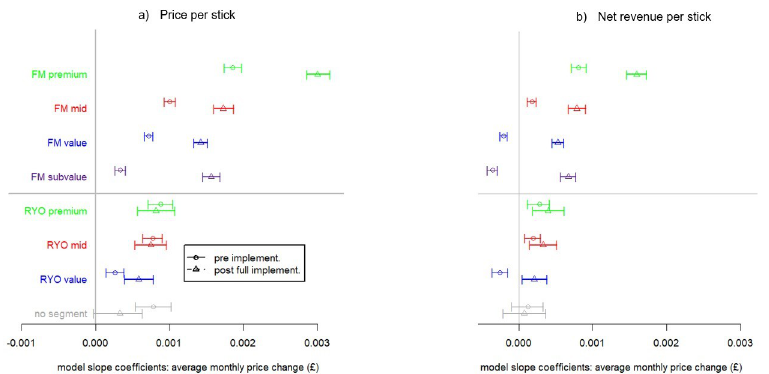
Fig 4. Forest plots of the pre- and post- implementation periods (June to March 2015/16 and 2017/18 respectively) showing mean monthly change in (a) weighted average price per stick and (b) weighted average net revenue per stick.